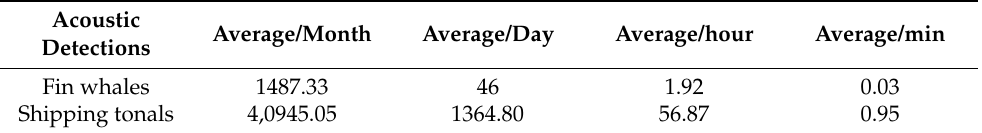
Table 2. Average number of fin whale and shipping tonal detections across months, days, hours, and minutes of the study period.